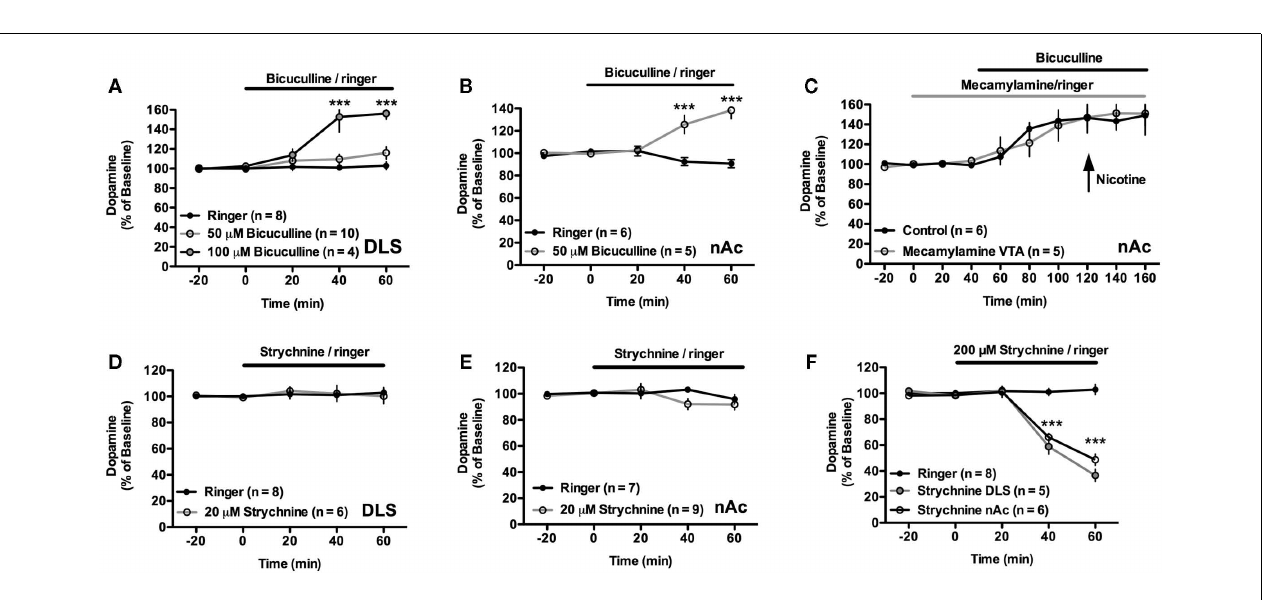
output induced by bicuculline administration in the nAc was not significantly modulated by mecamylamine co-perfused in theVTA. (D,E) The microdialysate concentration of dopamine was not depressed by 20 μ M strychnine in either brain region. (F) A higher concentration of strychnine (200 μ M) significantly depressed dopamine levels in both the DLS and in the